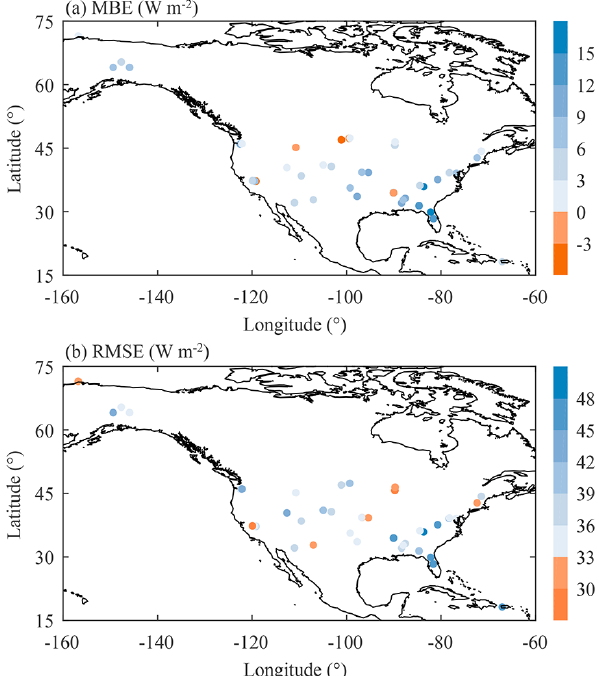
Figure 4. Spatial distribution of (a) MBE (Wm − 2 ) and (b) RMSE (Wm − 2 ) for our estimated instantaneous PAR product (ISCCP-ITP, 30km) at 7 SURFRAD stations and 42 NEON